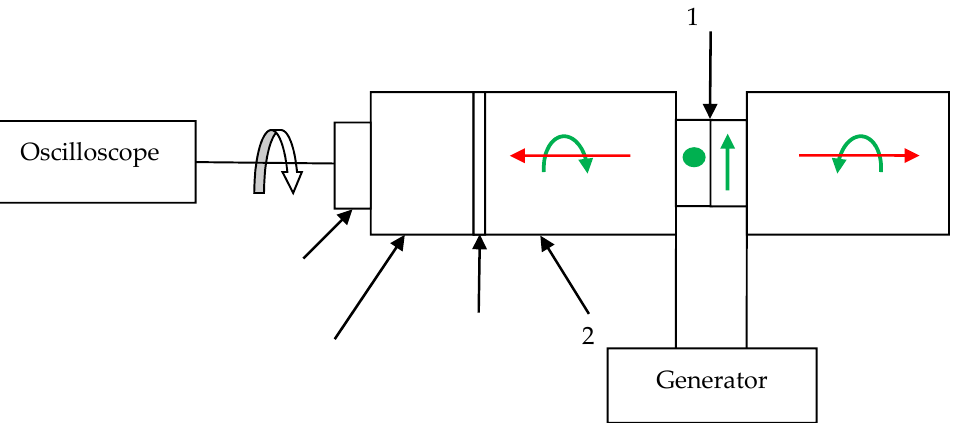
Figure 7. The scheme of experimental setup for CPAW transducer.